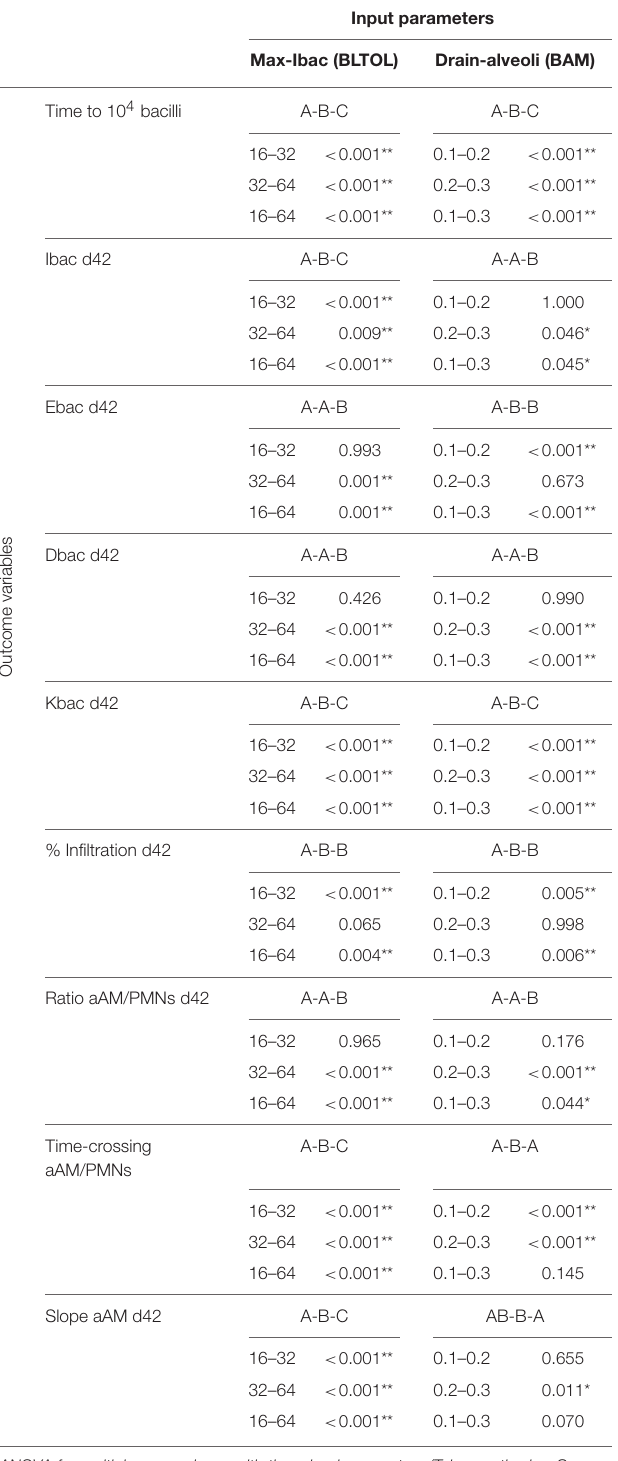
TABLE 2 | Multiple comparisons